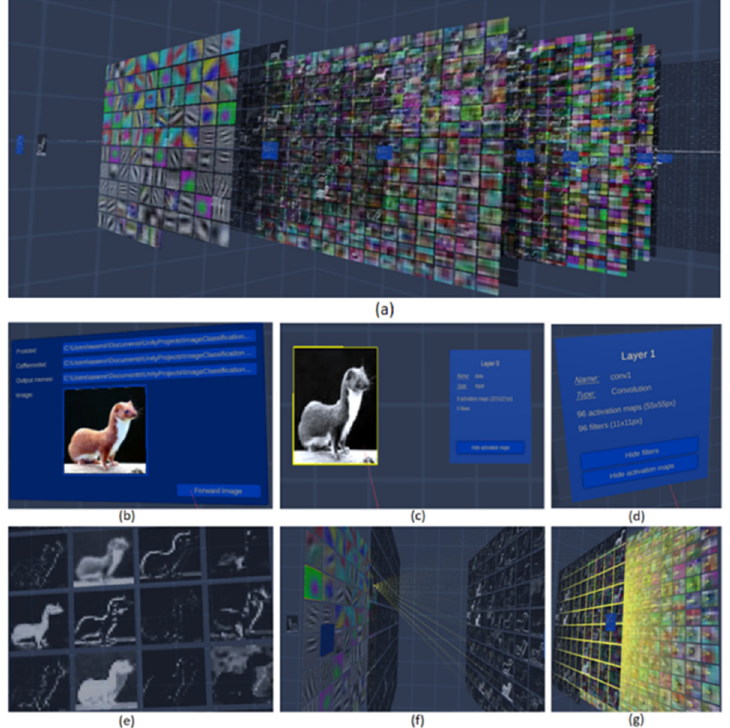
Figure 2. ( a ) An immersive visualization of different layers of the AlexNet architecture in Unity, ( b ) virtual GUI for selecting paths for model weights, CNN structure, labels, and input image, ( c ) input layer, ( d ) first convolutional layer icon, ( e ) snapshot of activation maps of the 1st convolutional layer, ( f ) selecting the connection of a particular filter of the 1st convolutional layer to visualize its activity across the network, and ( g ) deeper layer interactions of the selected filter. The user can visualize and hide filters and activation maps by selecting the corresponding option on the layer icon using a laser pointer.